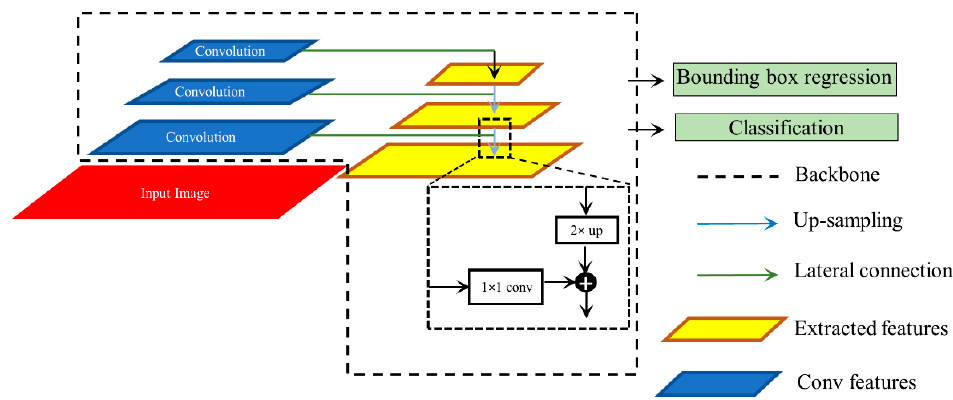
Figure 2. Method flowchart for the RetinaNet network.